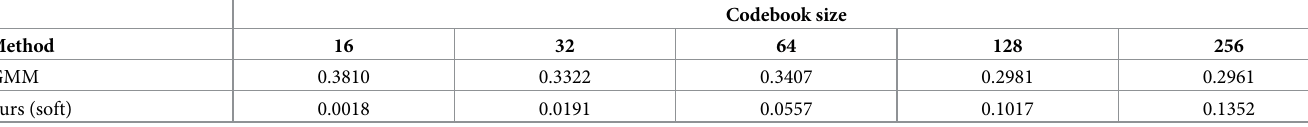
Table 11. The objective values of the GMM and ours with the soft objective with respect to the codebook size on the